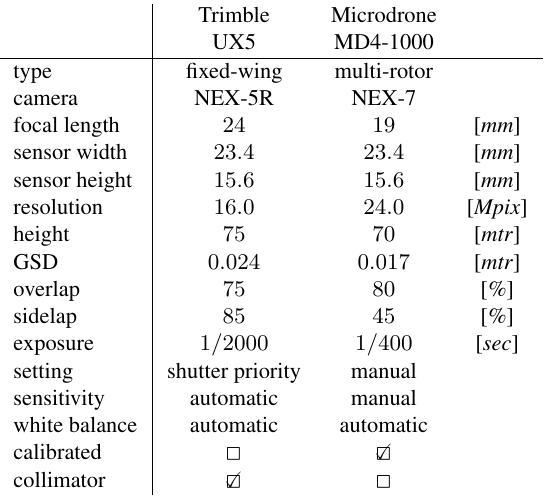
Table 1: Acquisition details of the two different platforms and flight specifications during the case study.